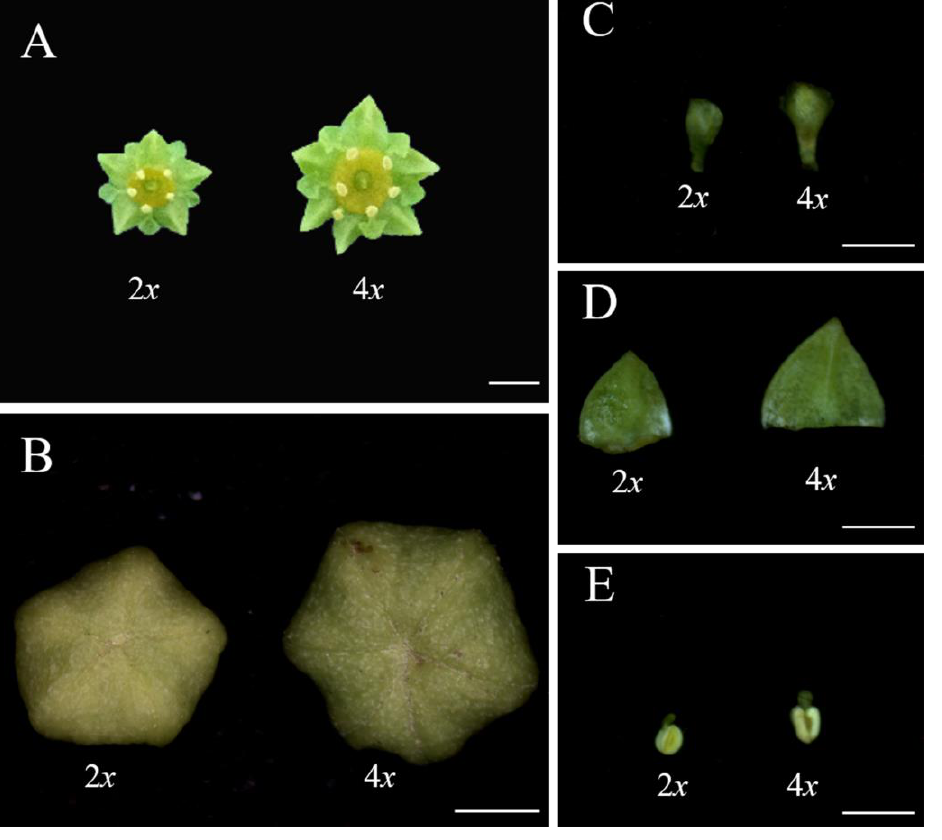
Table 2. Flower characteristics of ‘Xingtai0604′ and ‘Zhuguang’ .